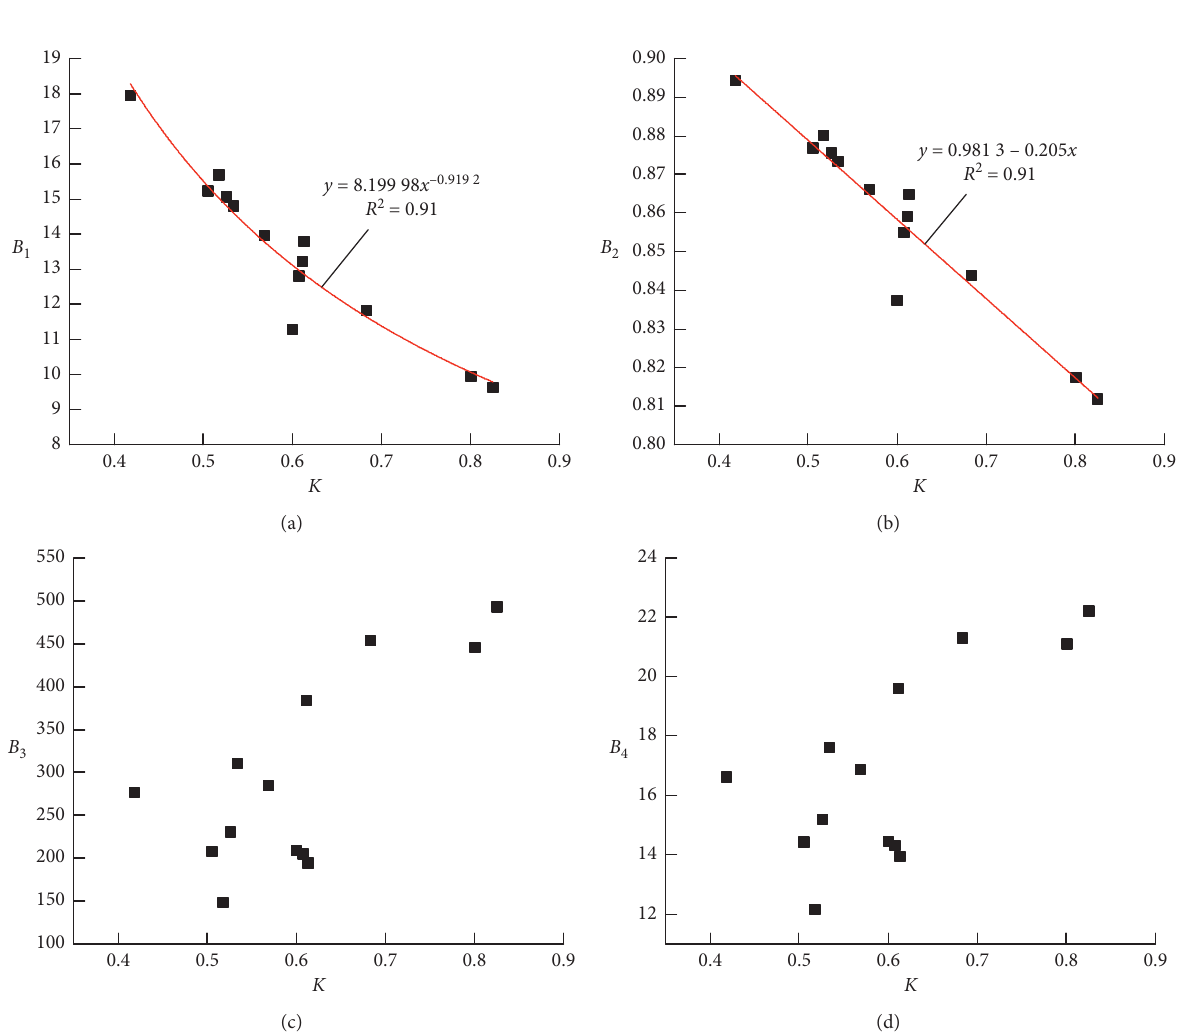
Figure 4: Relationship between crack initiation stress ratio K of gneiss and different brittleness indexes: (a) B